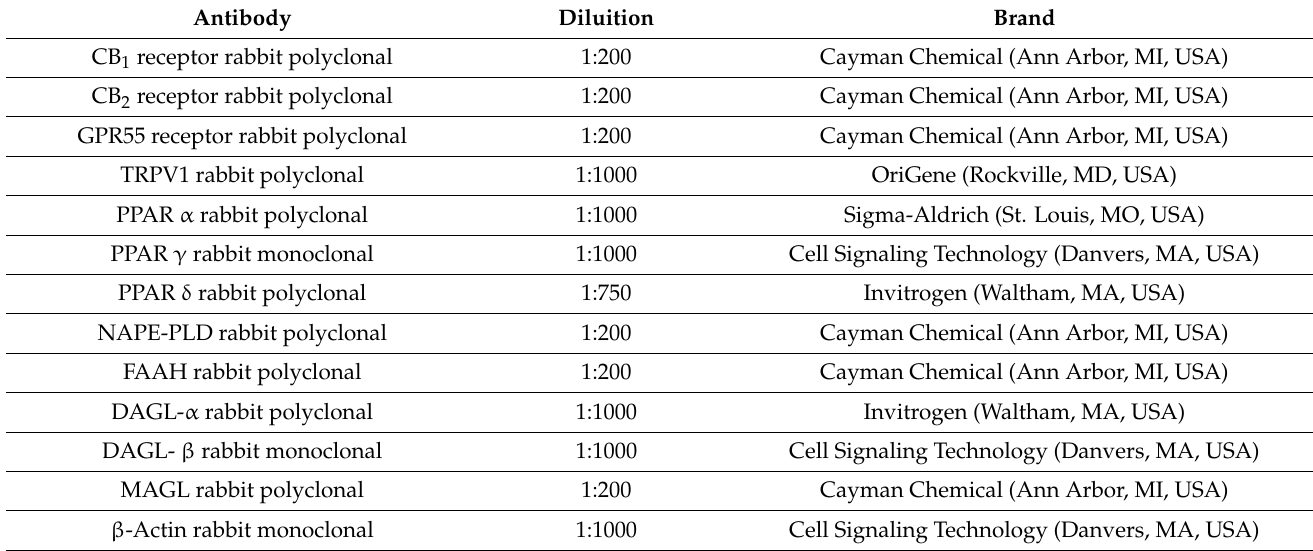
Table 6. List of antibodies used for Western blot